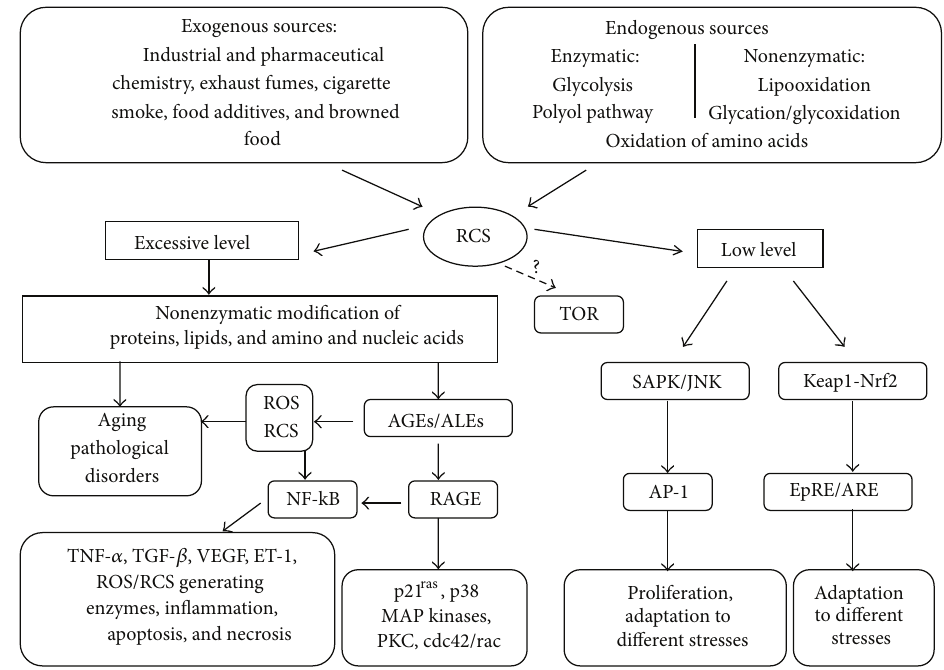
Figure 5: Involvement of reactive carbonyl species in signaling/transcription